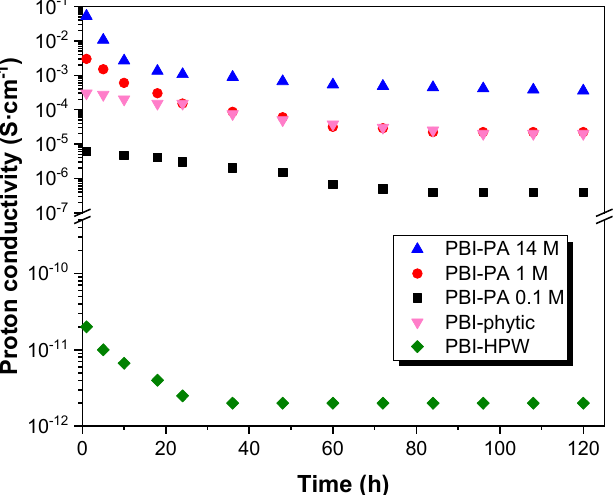
Figure 7. Long-term conductivity study at 160 ◦ C for PBI–PA 0.1 M ( (cid:4) ), PBI–PA 1 M ( • ), PBI–PA 14 M ( (cid:78) ), PBI–phytic acid (0.075 M) ( (cid:72) ), and PBI–HPW (0.1 M) ( (cid:7) ) membranes.